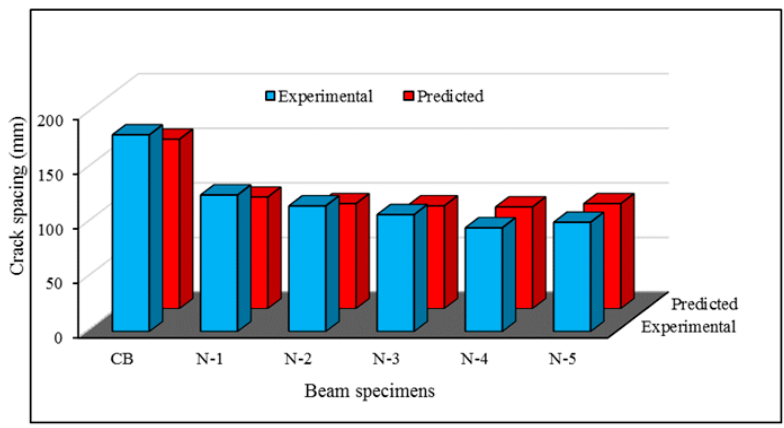
Figure 16. Comparison of experimental and predicted crack spacing.